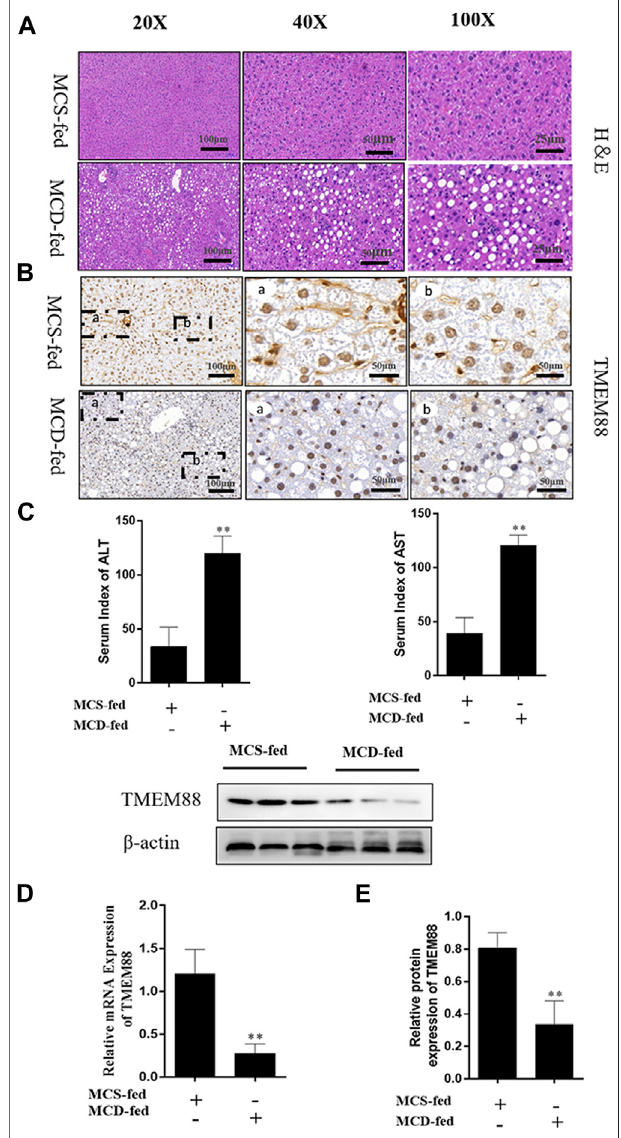
FIGURE 1 | TMEM88 expression was suppressed in NAFLD model. (A) The H&E stain in liver tissues. Fat vacuoles and intercellular spaces dilatation were appeared in NAFLD liver tissues, while the normal liver tissues indicated that normal lobular architecture. (B) Immunohistochemistry indicated that the expression of TMEM88 was reduced in MCD-fed mice liver tissues of (C) . The serum levels of ALT and AST in the MCD-fed group were increased. (D,E) RNA and protein results showed that compared with the normal group, TMEM88 was inhibited in MCD-fed mice. (Data are represented by at least three independent mean ± SD, * p < 0.05, ** p < 0.01 vs normal